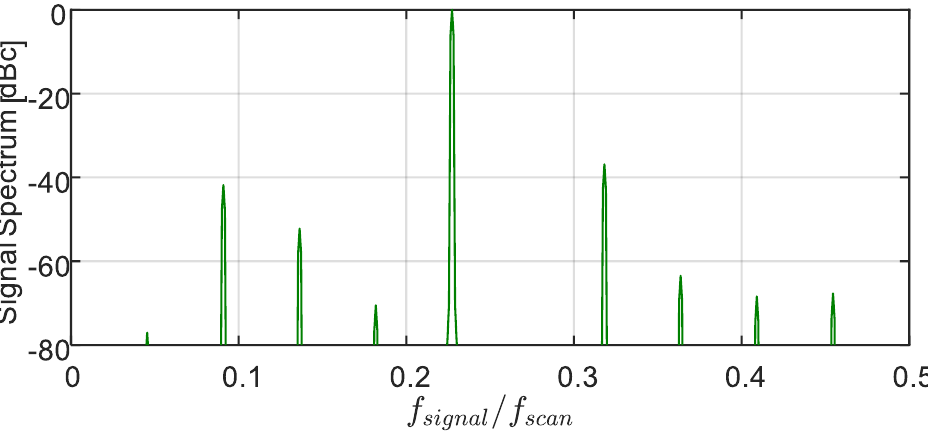
Figure 6. Spectrum of the pure sinusoidal signal of Figure 1, calculated from { ˆ s n , ˆ τ n } 549 , where { ˆ s n } are spline interpolated signal values on the computable uniform time grid { ˆ τ n } 549 , Equa- tion (4), based on the known sampled values { s n } and their actual sampling instants { τ n } 549 . Note the considerably lower harmonics, when compared with those of Figure 3.